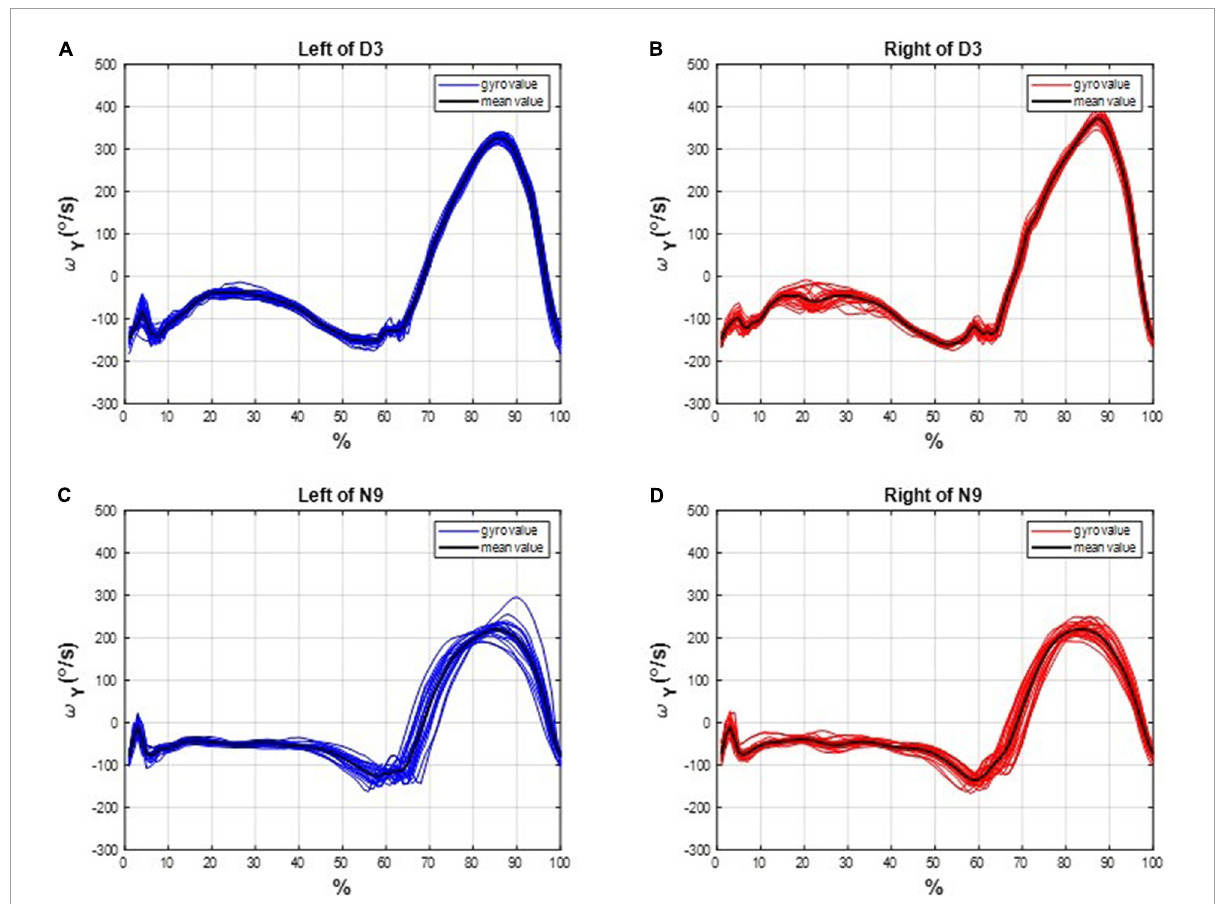
FIGURE4 The gait cycles of D3 and N9. The dancer tended to have more uniform gait cycles than the non-dancer control, which indicates a superiority of dancing training on gait performance. (A) On the left leg of D3. (B) On the right leg of D3. (C) On the left leg of N9. (D) On the right leg of N9.